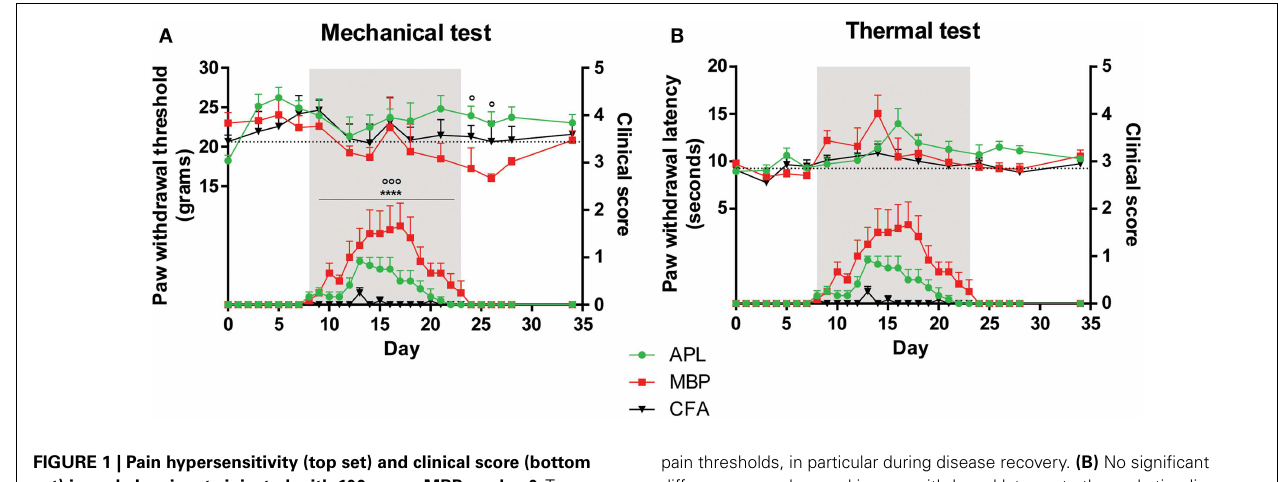
FIGURE 1 | Pain hypersensitivity (top set) and clinical score (bottom set) in male Lewis rats injected with 100 µ g gp-MBP on day 0 .Top series represent response to stimuli, while bottom series represent clinical score. EAE clinical scores of rats immunized with MBP were significantly greater than those of APL-treated or CFA-immunized (control) animals during period of established disease. (A) MBP-treated animals demonstrated a decrease in paw withdrawal thresholds to mechanical stimulus, while APL-treated animals had significantly elevated mechanical